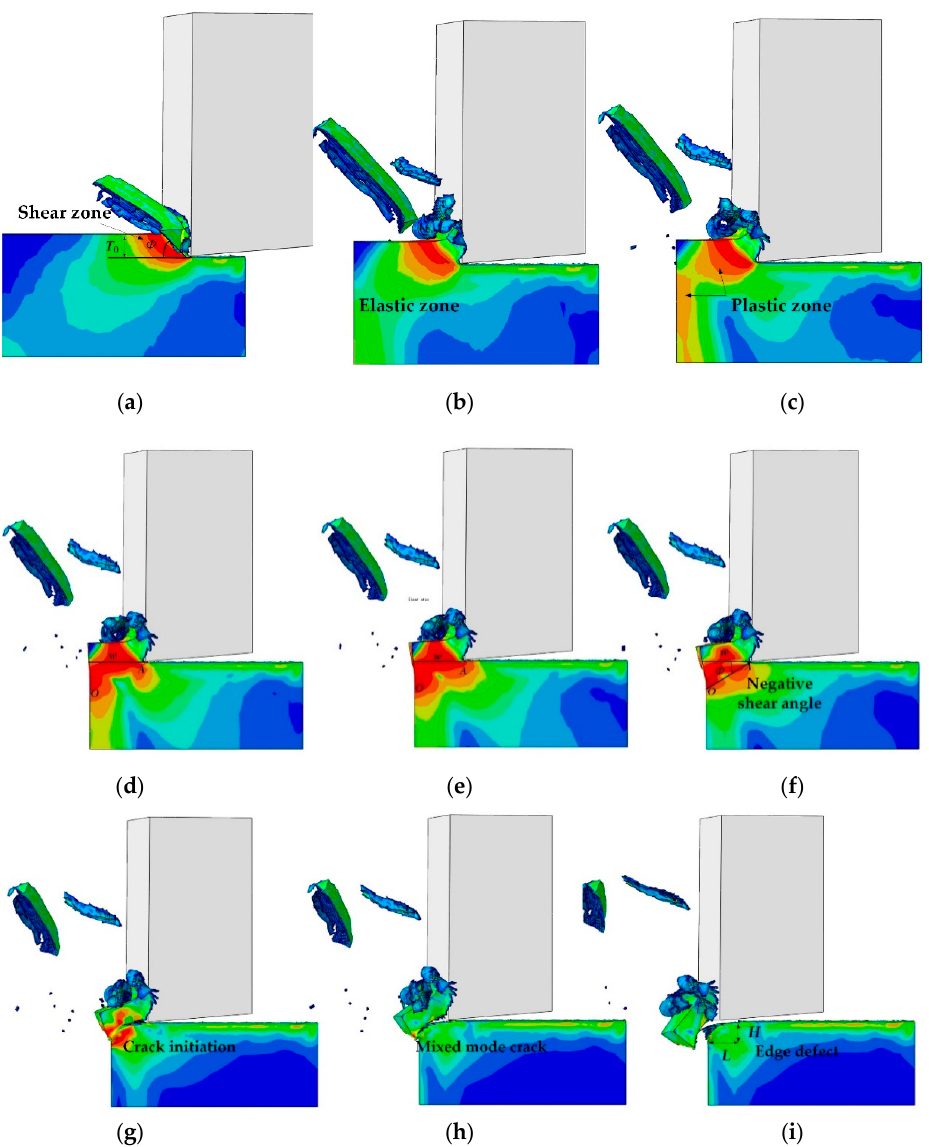
Figure 4. Process of edge defect